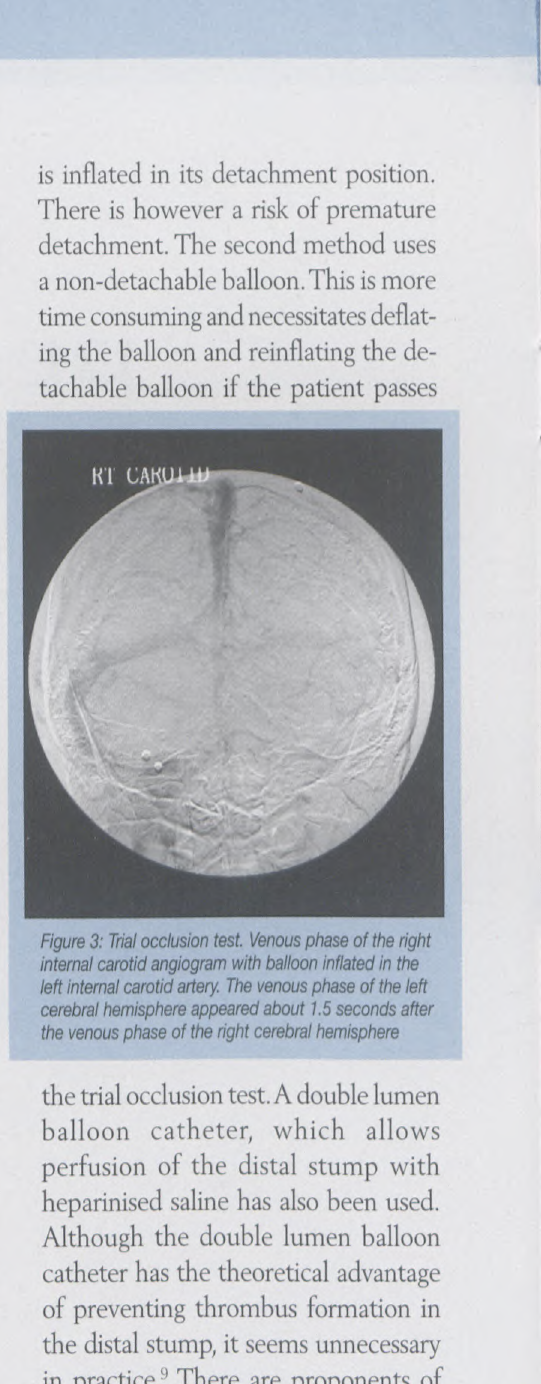
Figure 3: Trialocclusion test. Venousphase of the right internal carotid angiogram with balloon inflated in the left internal carotid artery The venous phase of the left cerebral hemisphere appeared about 1.5 seconds after the venous phase of the right cerebral